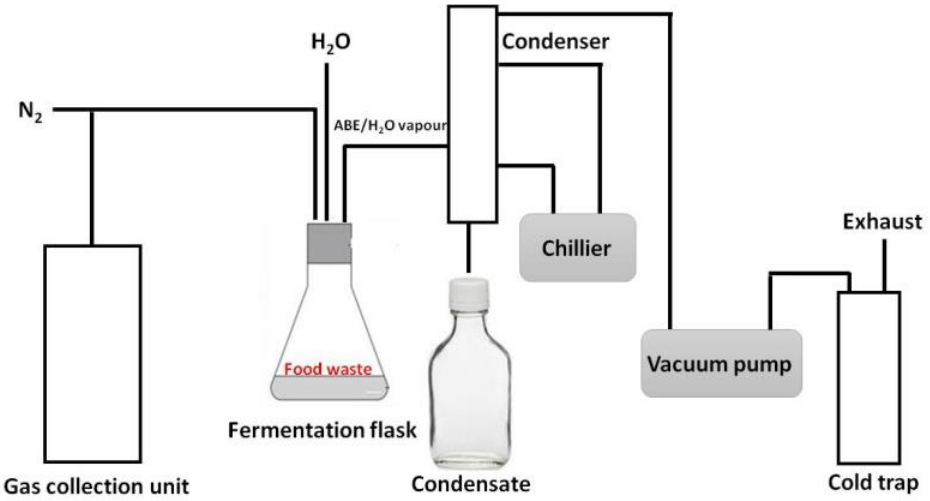
Figure 18. Design and development of a vacuum stripping system for removal of butanol during fermentation of food waste.